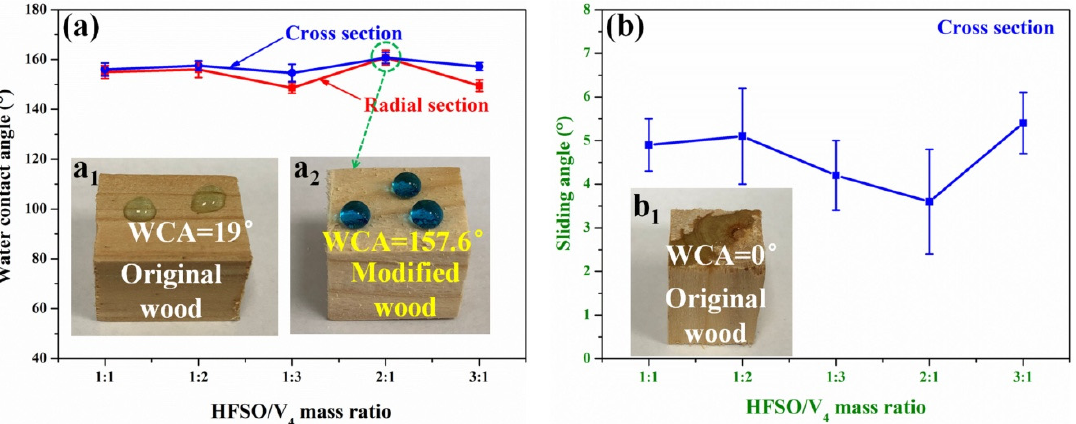
Figure 2. WCA ( a ) and SA ( b ) on wood surface at different HFSO/V 4 mass ratio. ( a 1 , a 2 , b 1 ) Methyl blue water droplets on original and treated wood